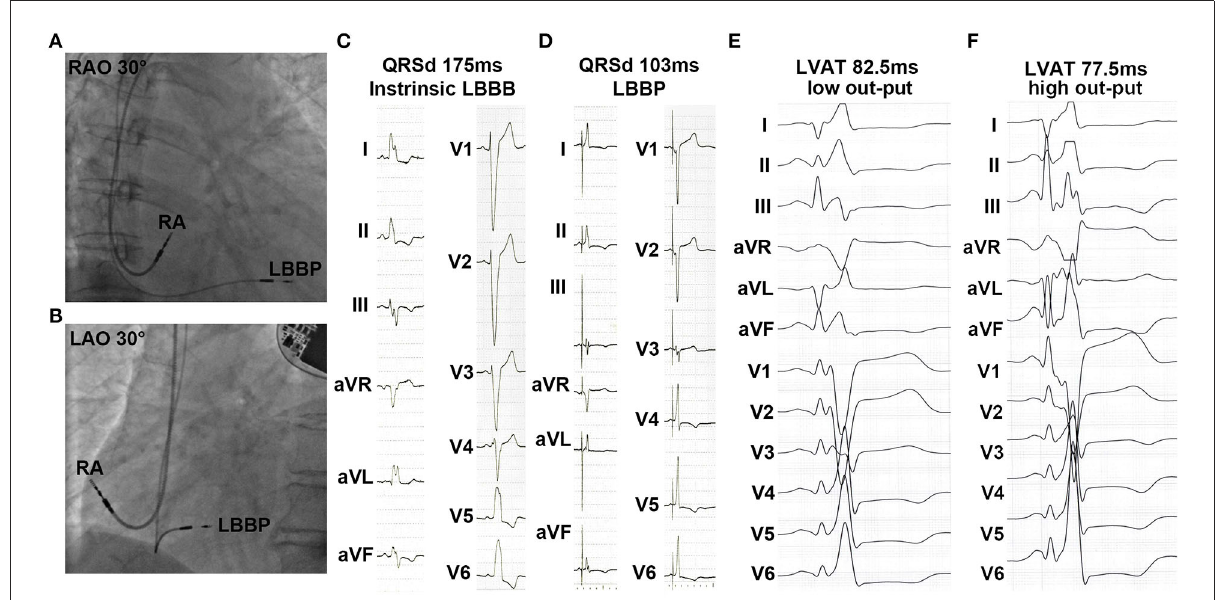
FIGURE1 Characteristics of left bundle branch pacing (LBBP) during implantation. (A,B) Right anterior oblique (RAO) and left anterior oblique (LAO) fluoroscopic images showed the sites of LBBP pacing lead. (C,D) Baseline QRS duration (QRSd) and paced QRSd upon pacing left bundle branch. (E,F) Sti-left ventricular activation time (LVAT) at low and high outputs.